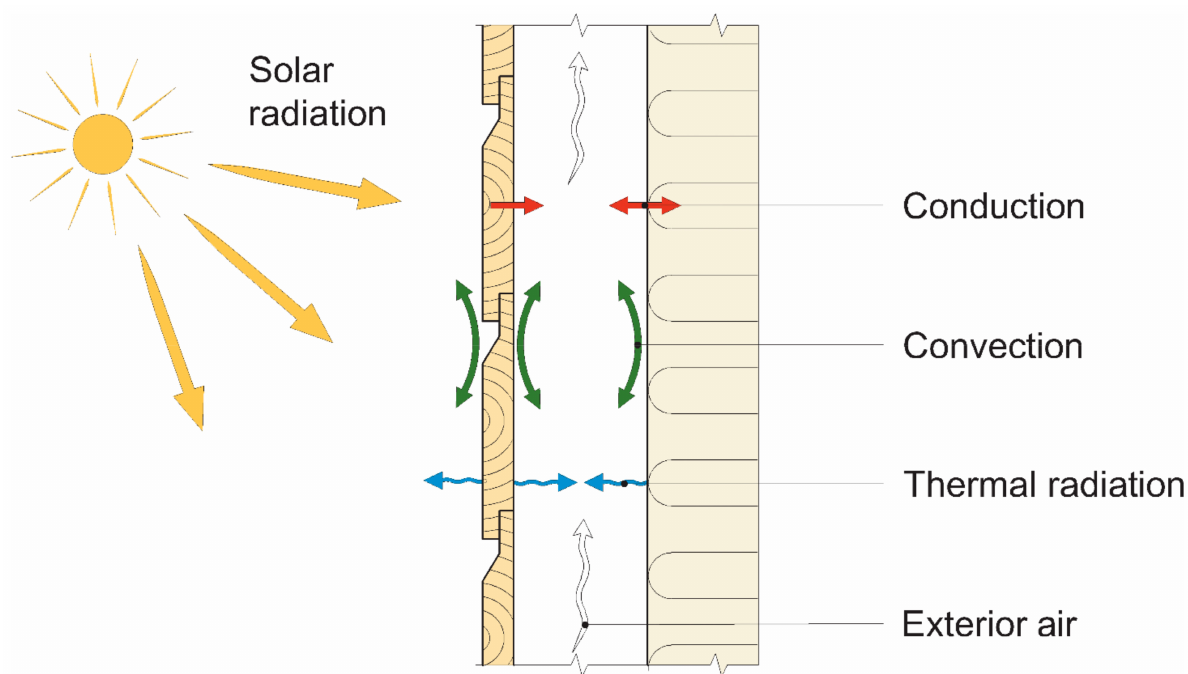
Figure 2. Heat transfer mechanisms in an air cavity. Figure drawn based on physics described by